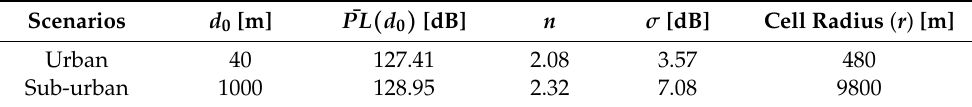
Table 2. Standard deviation of the path loss ( σ ) in dB and other parameters for the different deploy- ment scenarios. This table is partially adapted from [30] and based on the relevant values provided in [23,30].